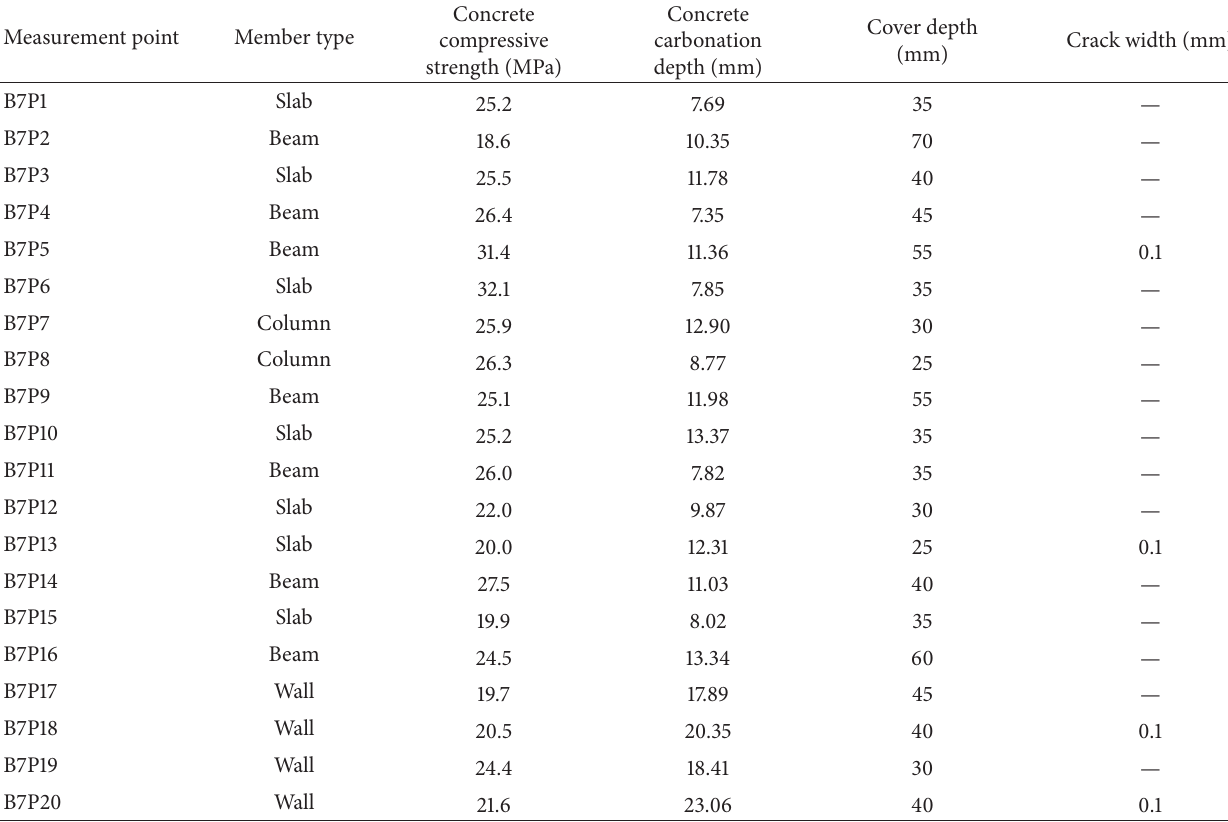
Table 9: Field investigation data (Building 7, construction completion year: